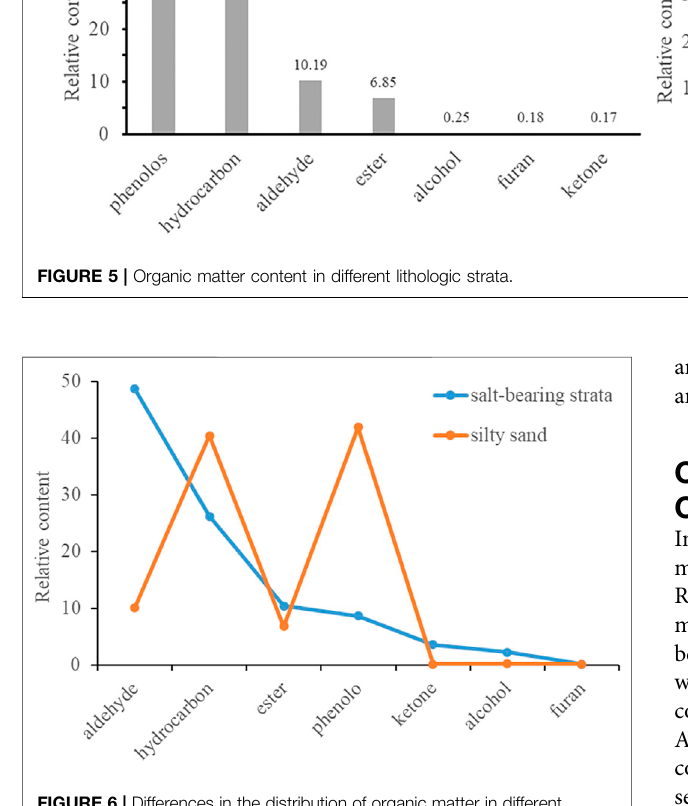
Frontiers in Earth Science |